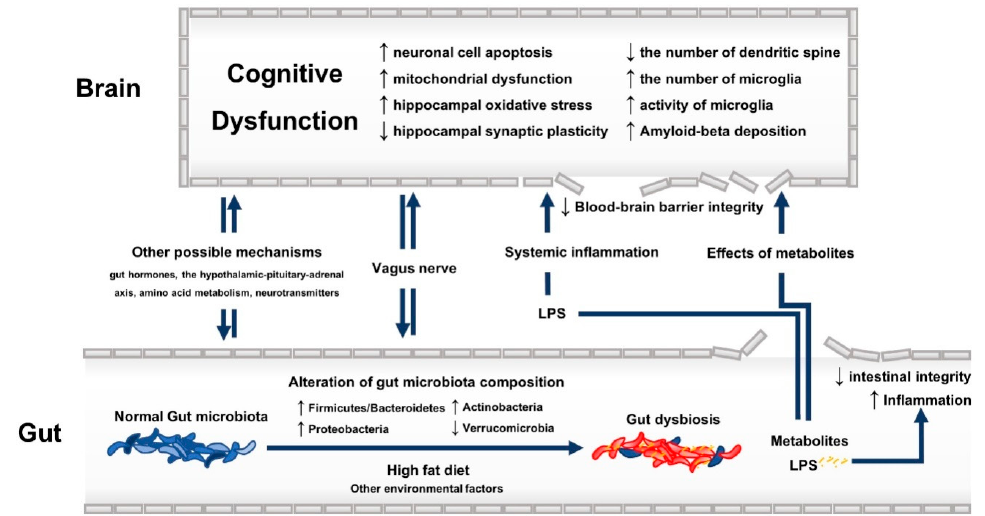
Figure 1. The possible underlying mechanisms of the association between gut dysbiosis and cognitive dysfunction. Up arrow: increased; down arrow: decreased